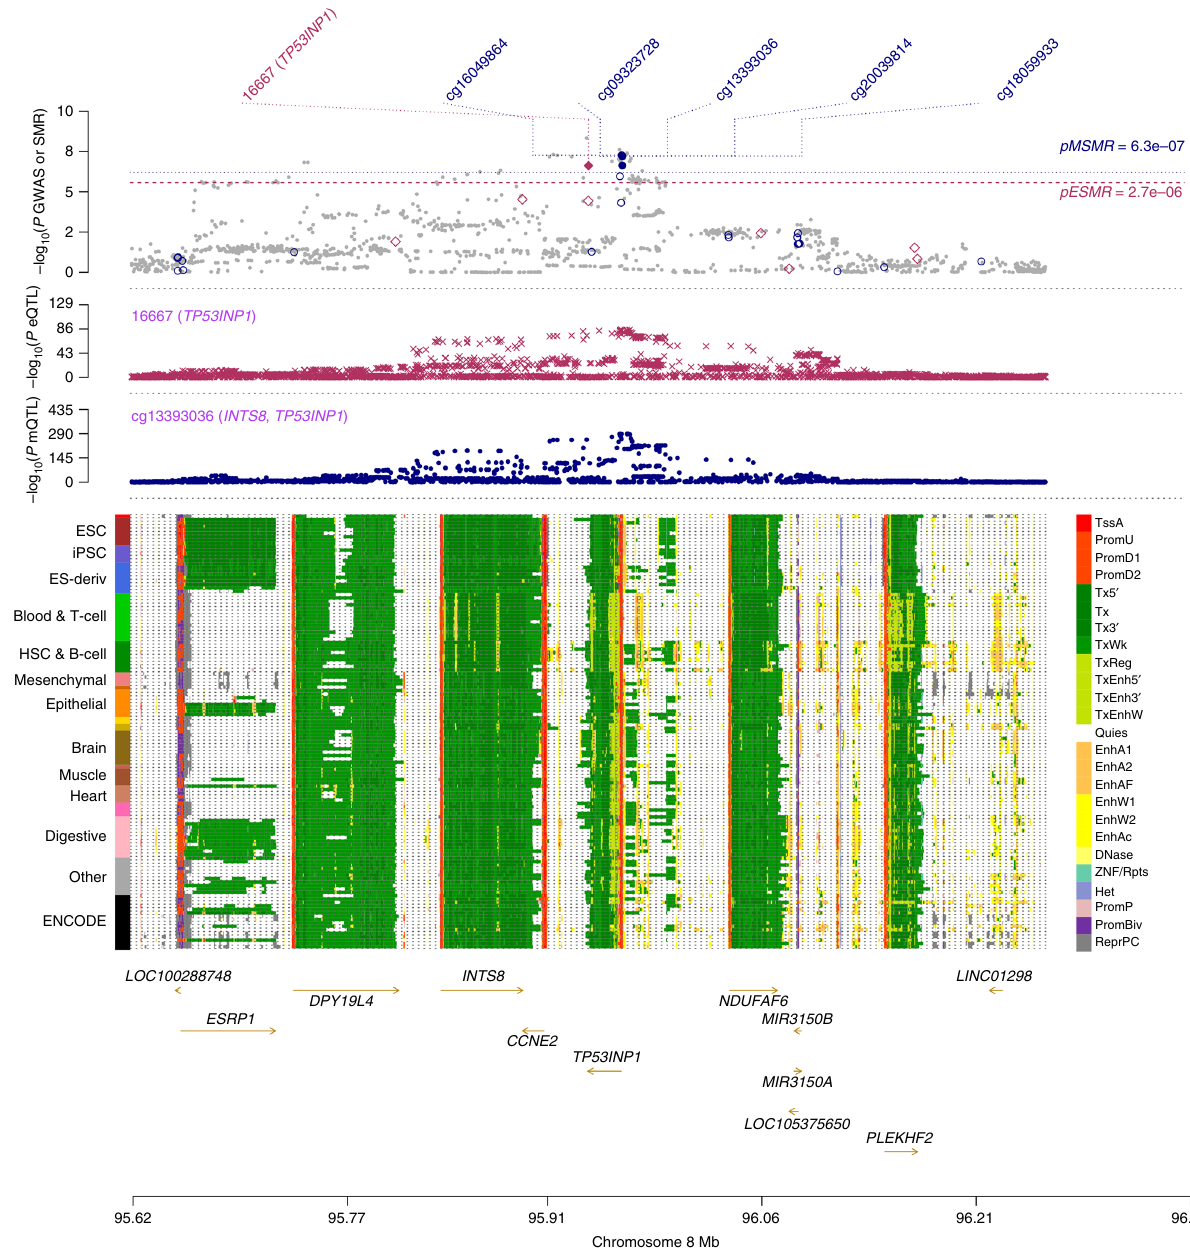
Fig. 4 Prioritizing genes and regulatory elements at TP53INP1 locus for T2D. Shown are the results from the SMR analysis that integrates data from GWAS, eQTL, and mQTL studies. The top plot shows − log 10 ( P value) from the GWAS meta-analysis for T2D. Red diamonds and blue circles represent − log P value) from the SMR tests for associations of gene expression and DNAm probes with T2D, respectively. Solid diamonds and circles represent 10 ( the probes not rejected by the HEIDI test. The second plot shows − log 10 ( P value) of the SNP association with gene expression probe 16667 (tagging TP53INP1 ). The third plot shows − log P value) of the SNP association with DNAm probe cg13393036 and cg09323728. The bottom plot shows 10 ( 25 chromatin state annotations (indicated by colors) of 127 samples from Roadmap Epigenomics Mapping Consortium (REMC) for different primary cells and tissue types